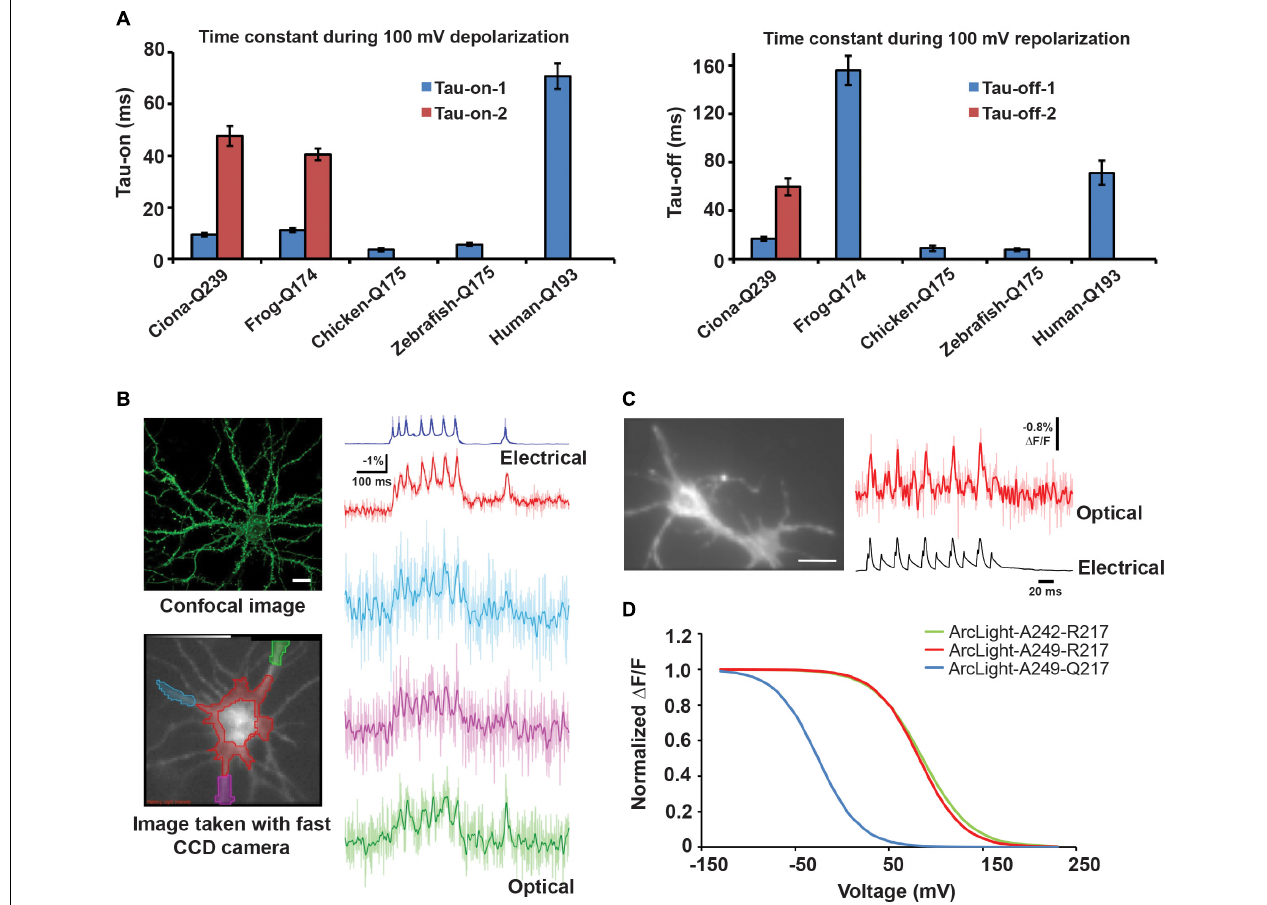
FIGURE 6 | Changing the VSD species or circular permutation of FP enhances GEVI kinetics (A) τ -on and τ -off of optical responses to 100 mV depolarization in HEK cells transfected with ArcLight derivatives based on frog, chicken, zebrafish or human voltage sensitive phosphatase ortholog. (B) Top left: confocal image of cultured hippocampal neuron expressing chicken ArcLight. Scale bar = 20 µ m. Bottom left: An 80 × 80 fast CCD camera image of a neuron from which electrical and optical recordings in the right panel were obtained. The ROIs are color coded to match those of the respective optical traces. Right: Single trial recordings of evoked APs using chicken ArcLight. The somatic and neurite recordings were low-pass filtered with a 95 and 50 Hz Gaussian filter, respectively. The unfiltered traces are shown as light-colored lines. (C) Left: Wide-field image of a hippocampal neuron expressing ElectricPk. Scale bar = 15 µ m. Right: Single (light red trace) and averaged (red trace) optical and electrical responses to evoked APs in the neuron on the left. The optical responses were captured using a NeuroCCD camera (RedShirt Imaging, LLC) at 2 kHz. (D) Normalized (cid:49) V / (cid:49) F curves for ArcLight derivatives A242–R217, S249–R217, and S249–Q217. 242 and 249 represent sites of FP fusion on the Ci VSD linker. 217 refers to the outermost arginine on the S4 helix (Barnett et al., 2012; Han et al., 2013, 2014).